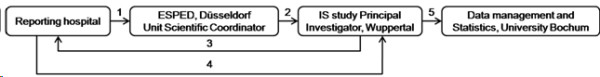
Structure of the ESPED reporting system (IS reporting).